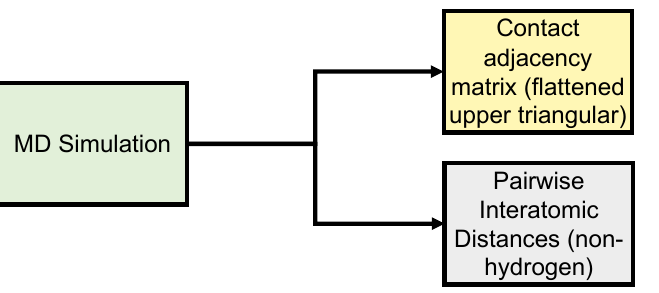
Figure 2. Data generation of input (upper triangle of PSN adjacency matrices) and output (upper triangular of PIDs)